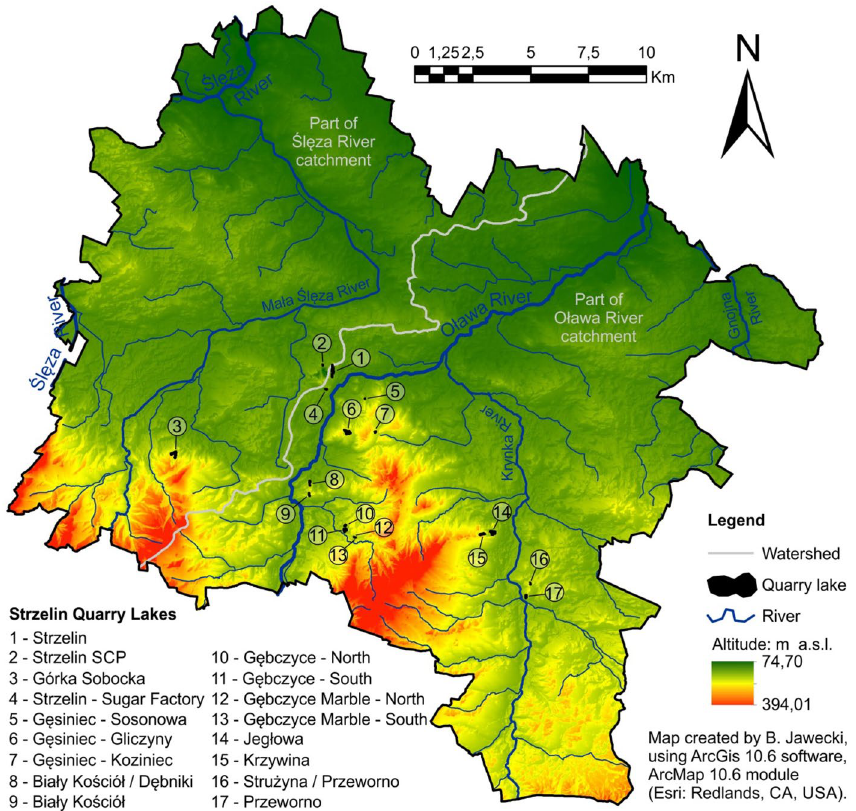
Figure 2. The location of Strzelin Quarry Lakes on the background of the hydrographic network of Strzelin